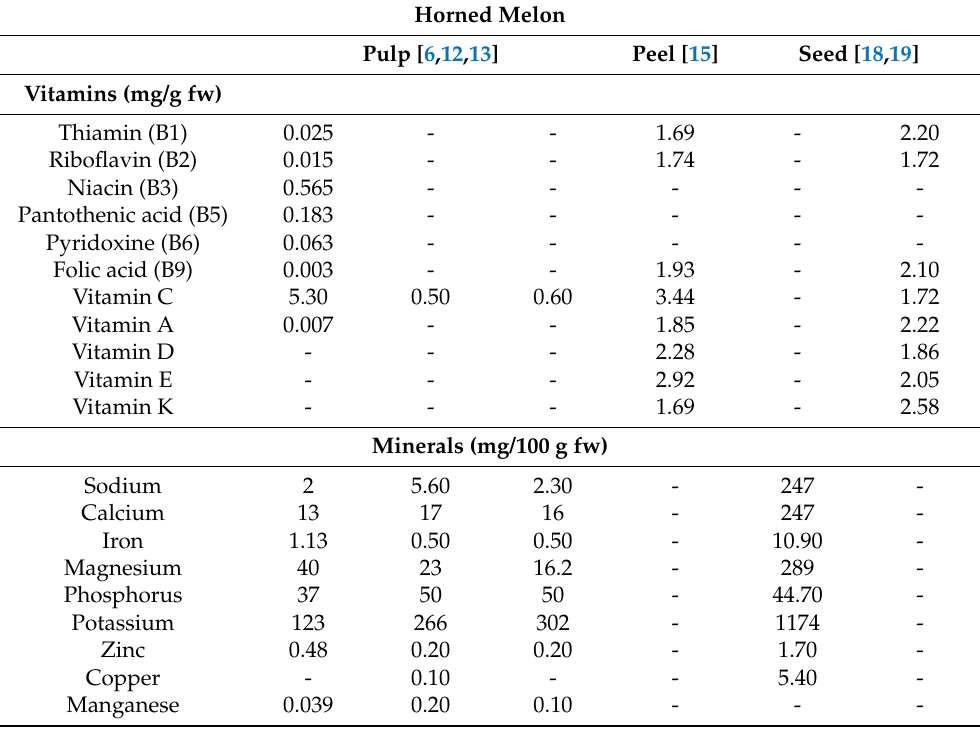
Table 2. Vitamin and mineral contents of horned melon pulp, peel, and seed. fw—fresh